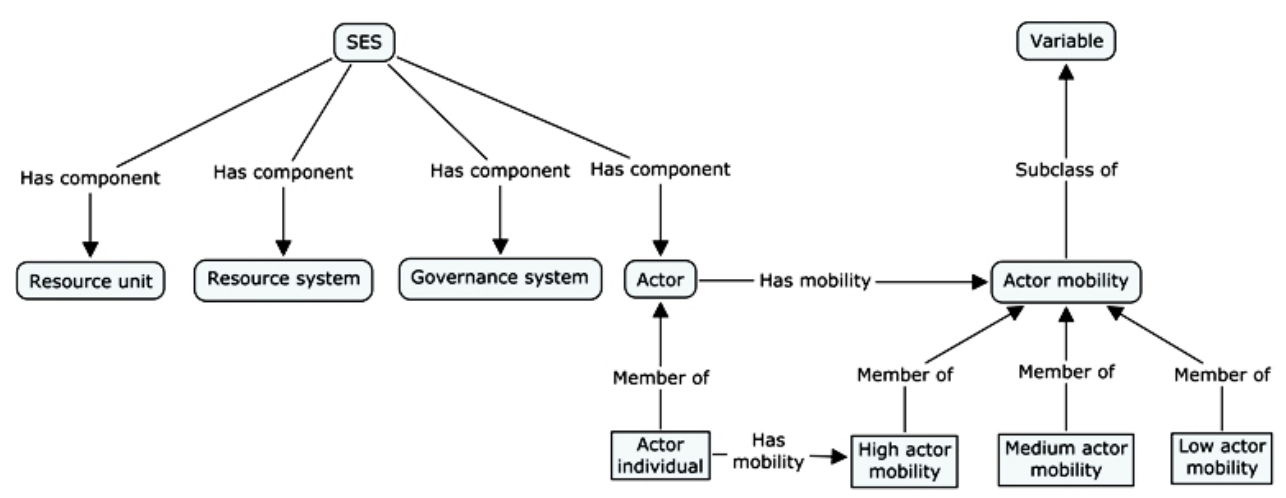
Fig. 2 . Formalizing the social-ecological system (SES) framework.